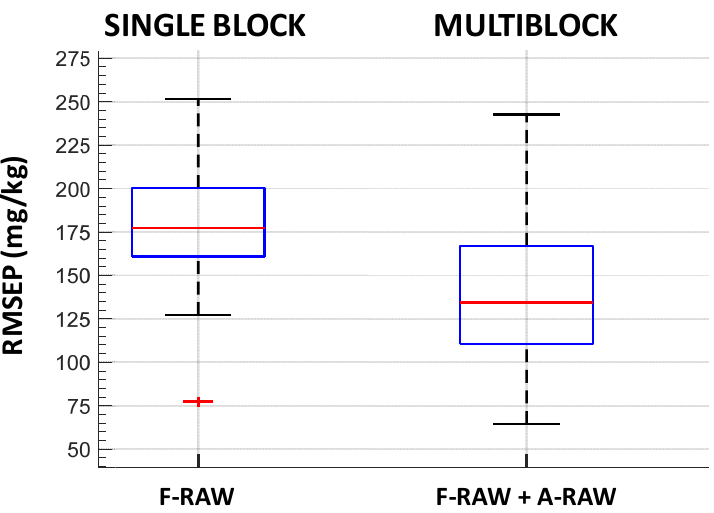
Figure 4. RMSEP boxplots of 50 iterations of the double cross-validation: on the left for PLSR model with fluorescence raw data; on the right for multiblock SO-PLS model with fluorescence and absorbance raw data. Bottom and top edges of the blue box are the 25th and 75th percentiles, respectively; the central mark is the median; whiskers extend to the most extreme data points not considered outliers; the ‘+’ symbol plots outliers.